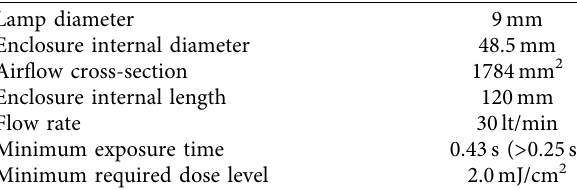
Figure 5: Parts of the device that are used with the enclosure. Table 3: Design parameters of the UV-C